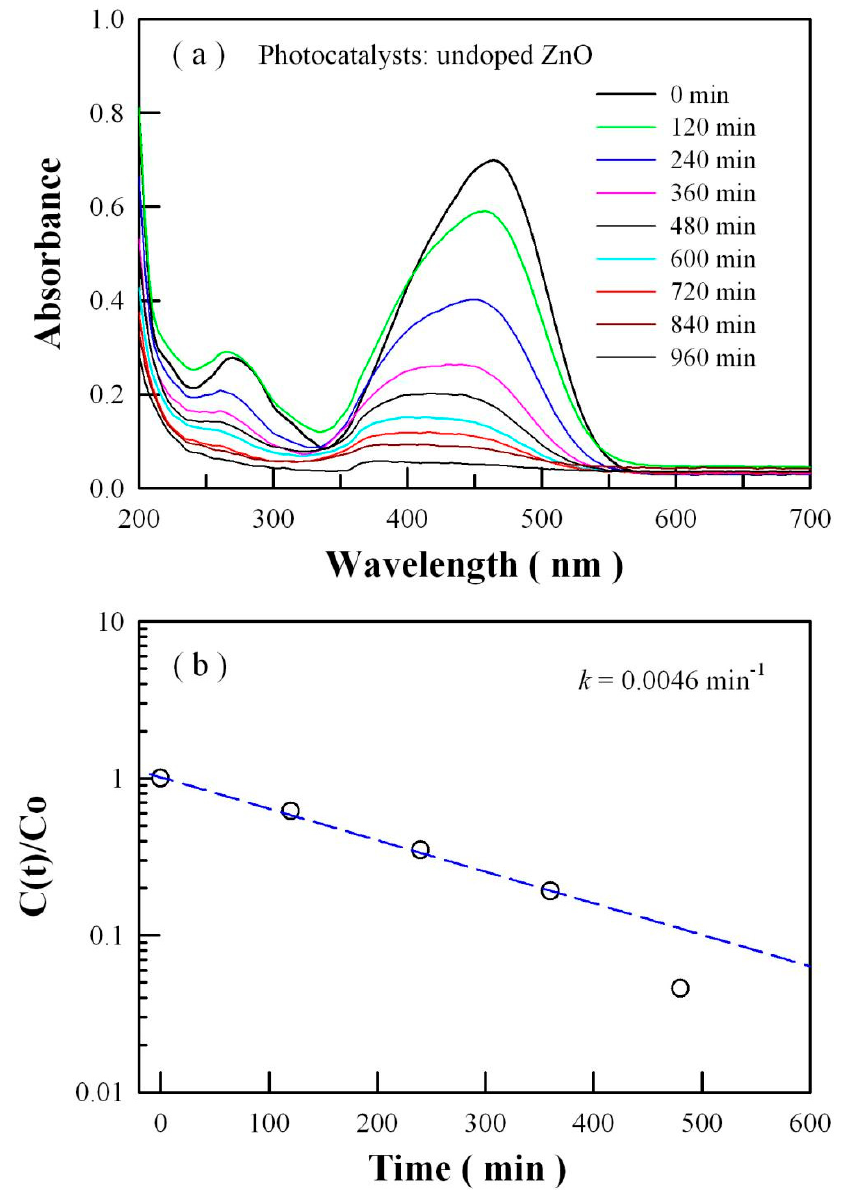
Figure 6. ( a ) UV-Vis absorption spectra of methyl orange solution as a function of visible-light irradiation time with the loading of undoped ZnO nanocrystals. ( b ) Semilogarithmic plots of Ct / Co as a function of visible-light irradiation time for undoped ZnO nanoparticles.